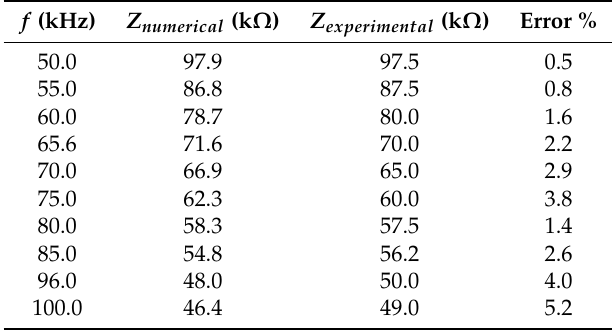
Table 2. Comparison between calculated impedance from Equation (19) with the experimental one extracted from Figure 2b and their respective